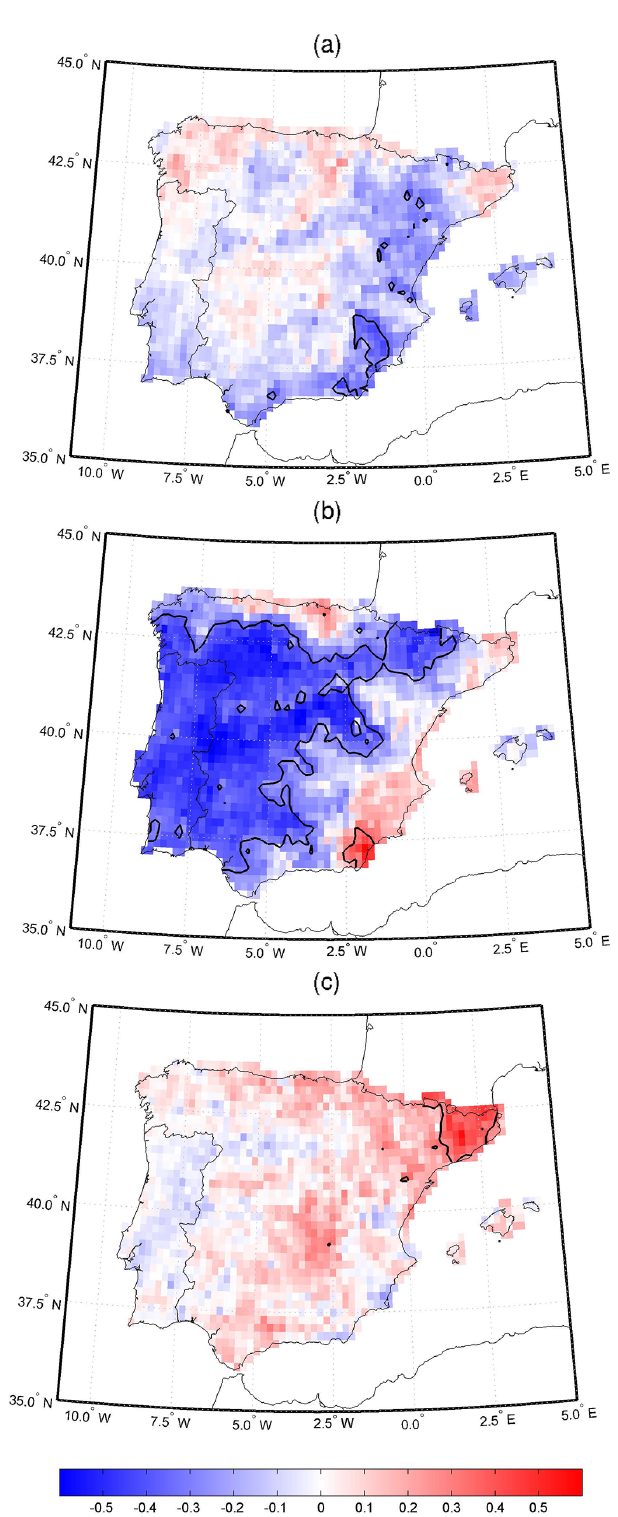
Figure 2. Correlation map between winter (JFM) precipitation of the Iberian Peninsula and the FTLE anomalies for the eastern Atlantic region ( [ 30 ◦ W , 0 ◦ W ]×[ 25 ◦ N , 65 ◦ N ] ) for the three previous seasons: (a) spring (AMJ), (b) summer (JAS) and (c) autumn (OND). The black lines mark the significant correlation at 95% according to the Student’s t